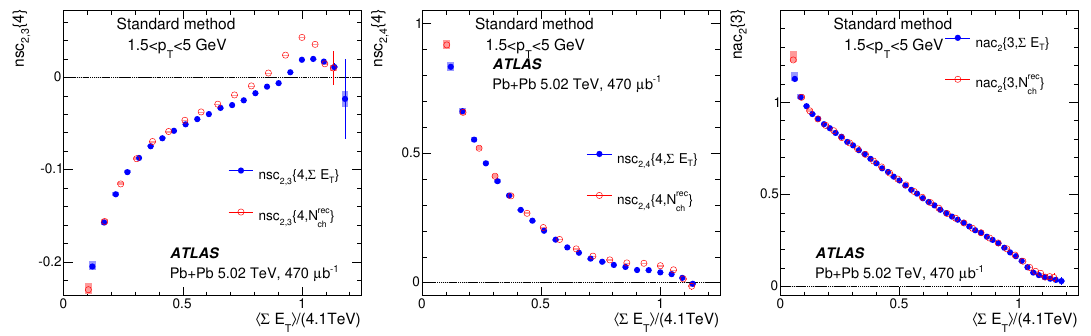
Figure 20 . Comparison of nsc 2 ; 3 f 4 ; (cid:6) E T g and nsc 2 ; 3 f 4 ; N rec nsc 2 ; 4 f 4 ; N rec g (middle panels), and nac 2 f 3 ; (cid:6) E T g and nac 2 f 3 ; N rec ch of h (cid:6) E T i . The error bars and shaded boxes represent the statistical and systematic uncertainties, respectively. Zero is indicated by a dotted